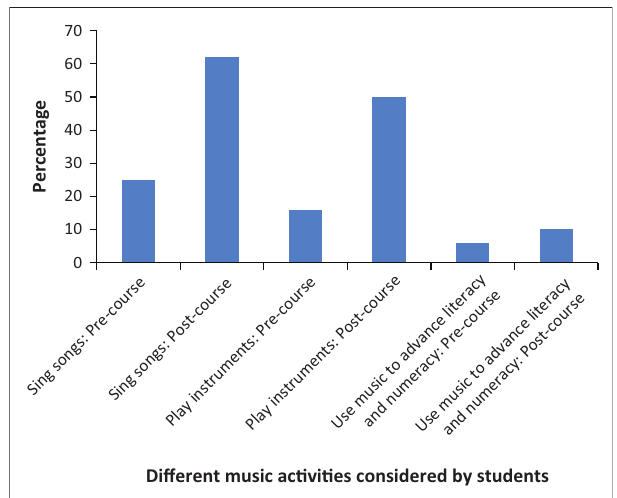
Different music ac(cid:16)vi(cid:16)es considered by students FIGURE 8: Pre- and post-course music activities students considered to offer to children.